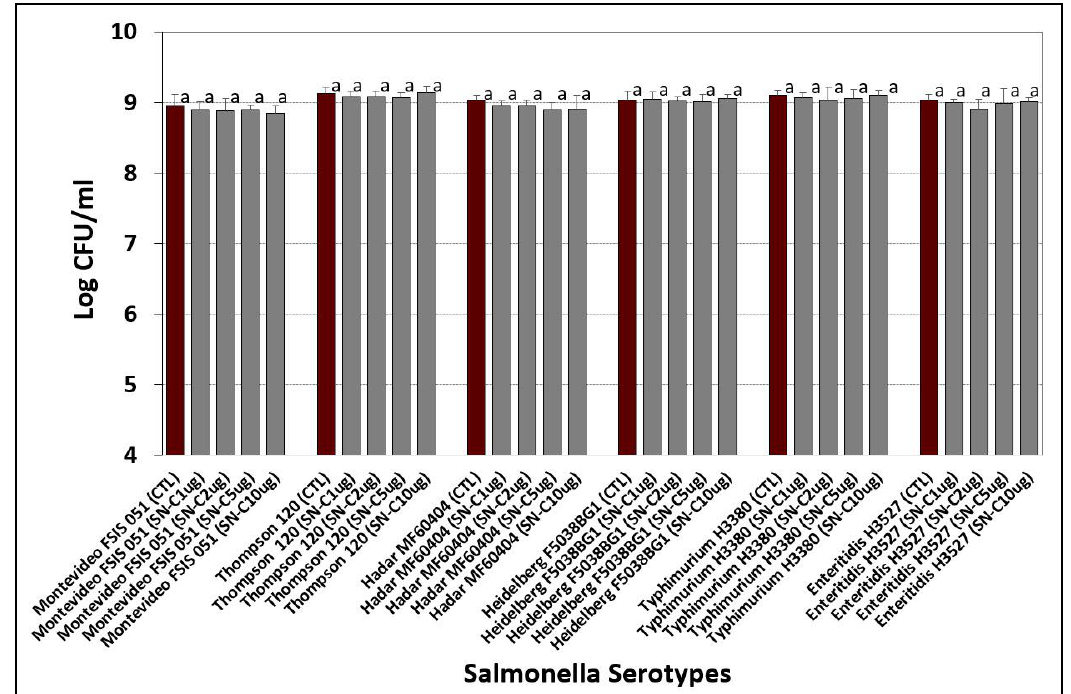
Figure 3. Evaluation of Salmonella serovars on TSA alone as Control (CTL) vs. TSA containing